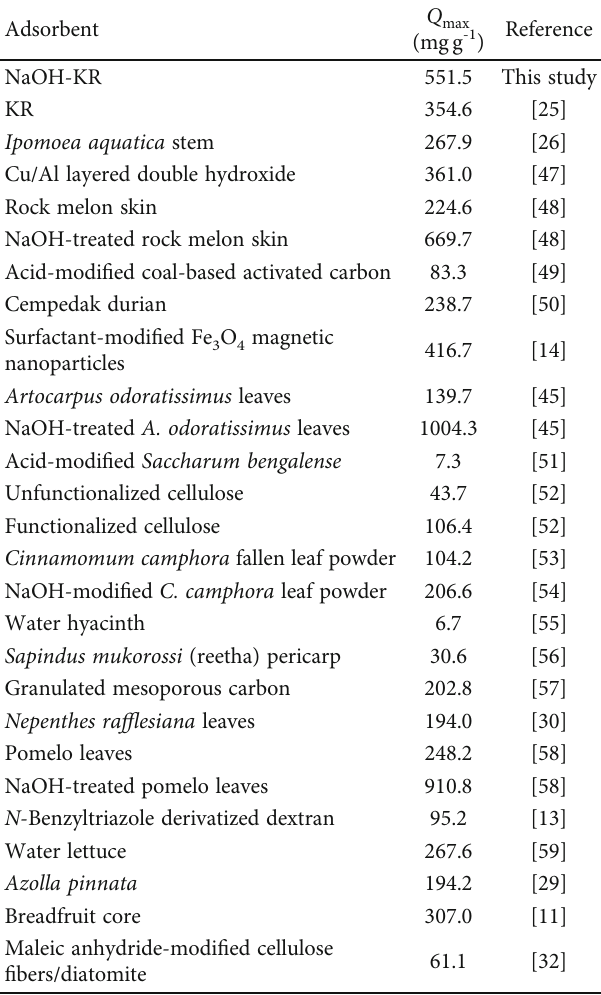
Figure 4: Simulation plots of Langmuir (blue line), Freundlich (green line), Temkin (black line), R-P (purple line), and Sips (yellow line) compared with the experimental data (black circle) obtained (mass of adsorbent = 0 : 020 g; volume of MV solution = 10 : 0 mL; concentration of MV = 0 to 1000 mgL -1 ). Table 3: Comparison of the Q max values of reported